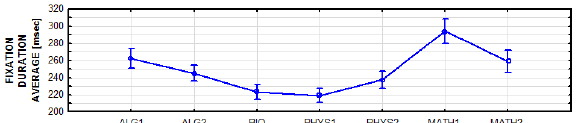
Figure 7. The fixation duration average - a distribution of the mean values for the particular tasks.